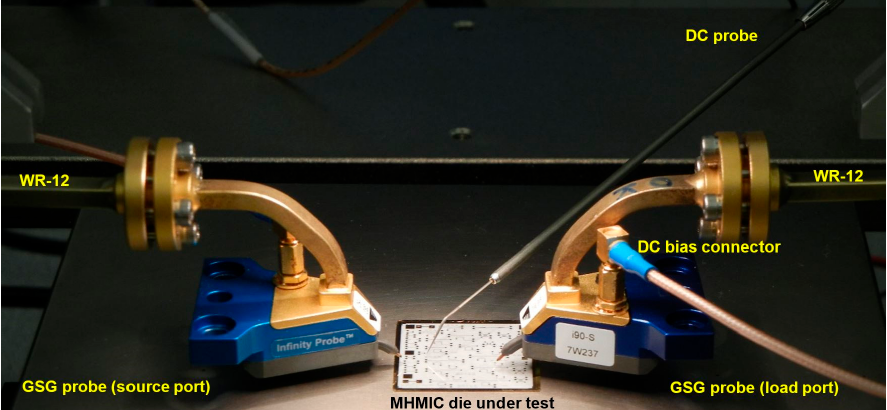
Figure 24. Measurement set-up: MHMIC circuit under test, DC continuity test box, probes. Sensors 2020 , 20 , x FOR PEER REVIEW